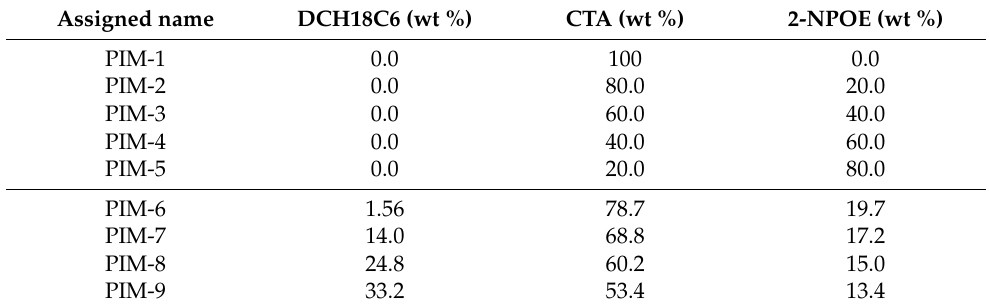
Table 2. Weight percentage (wt %) of DCH18C6, CTA and 2-NPOE for each of the prepared